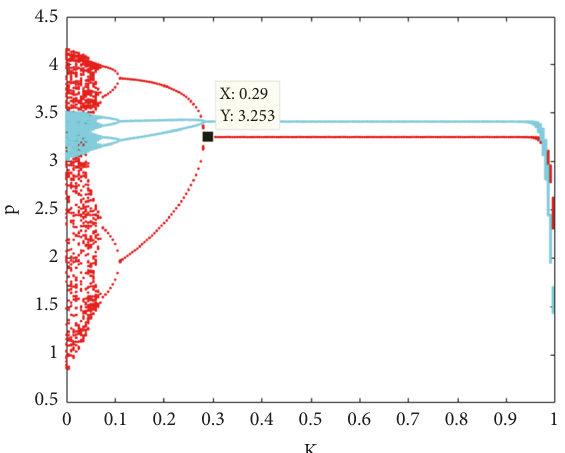
Figure 15: Bifurcation diagram with change of the control parame- ter